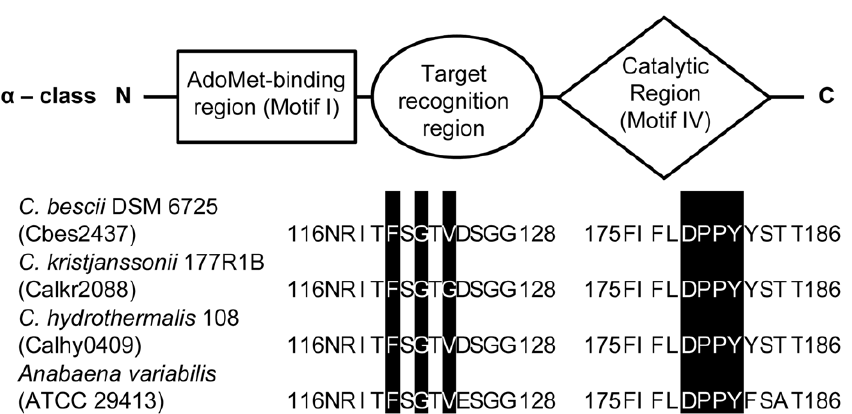
Figure 4. Domain structure of M.CbeI. Predicted functional domains of M.CbeI and sequence alignments of conserved motifs of three M.CbeI homologues from members of Caldicellulosiruptor species as well as DmtB from Anabaena variabilis , which also contains an M.CbeI homologue showing unique features of this methyltransferase.